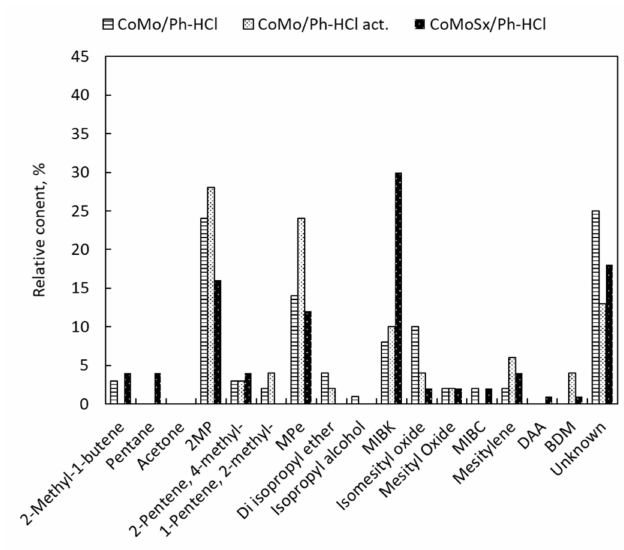
Figure 9. Compounds present in the organic liquid product for the tests using CoMo/Ph-HCl type catalysts. CoMo/Ph-HCl catalyst was used directly, CoMo/Ph-HCl catalyst was previously reduced in hydrogen atmosphere and CoMoSx/Ph-HCl material was previously treated for the sulfidation of the metal